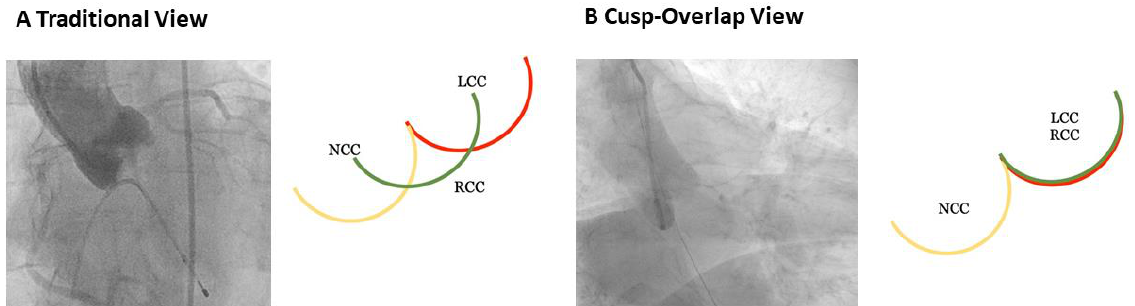
Figure 5. Optimizing fluoroscopic projections for transcatheter aortic valve implantation (TAVI). Panel ( A ) shows the basal aortography of the optimal projection for self-expandable valve implantation (“3 cusp view”), the nadirs of the three cusps (yellow = non-coronary [NCC], green = right-coronary [RCC], red = left-coronary [LCC]) are perfectly coplanar and equally spaced. Panel ( B ) shows an aortography of a cusp-overlap view obtained by overlapping the right-coronary cusp and the left-coronary cusp, isolating the non-coronary cusp and allowing to minimize interaction with the conduction system.